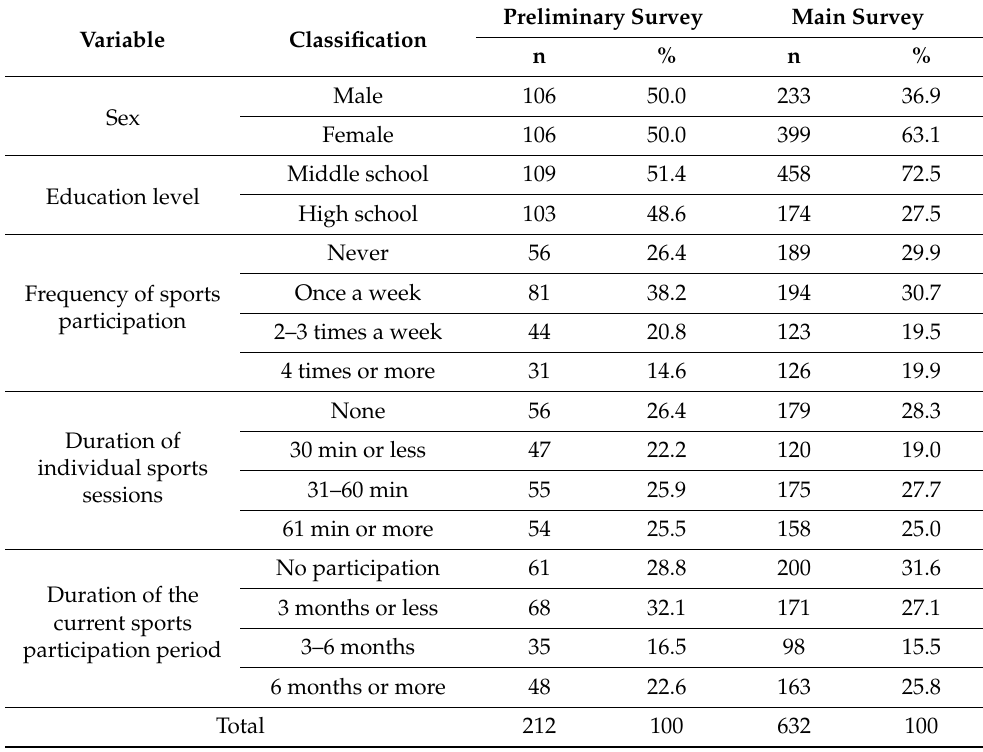
Table 1. Participants’ demographic